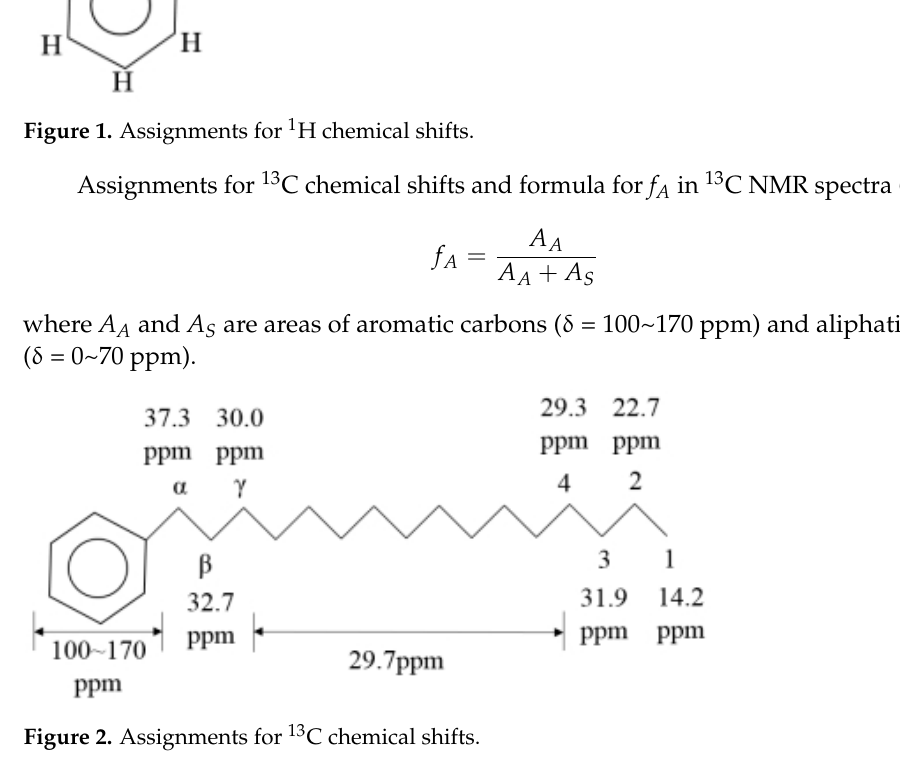
Figure 2. Assignments for 13 C chemical shifts.